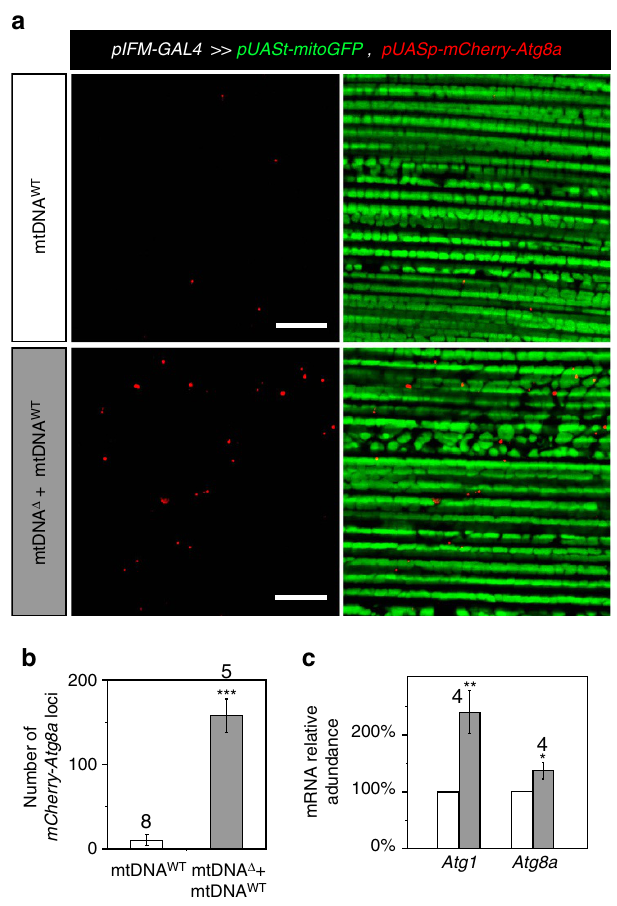
Figure 4 | Evidence for induction of autophagy in response to mtDNA D . ( a ) IFM from a 3-day-old wild-type animal expressing mitochondria- localized GFP ( mitoGFP ; green) and mCherry-Atg8a (red) under the control of pIFM-GAL4 (top panels), and a mitoAflIII -expressing, mtDNA D -bearing animal (lower panels). Scale bar, 10 m M. ( b ) Histogram quantifying abundance of mCherry-Atg8A associated structures in wild-type and mtDNA D -bearing IFMs. ( c ) Relative mRNA abundance of Atg1 and Atg8a in wild-type IFMs (mtDNA WT ), and IFMs from mitoAflIII animals containing mtDNA D (mtDNA D þ mtDNA WT ), at 3 days post eclosion. Bars depict mean ± 1 s.d. The number of biological replicate is indicated above the corresponding bars. Statistical significance was calculated using Student’s t- test with unequal variance. * P o 0.05, ** P o 0.01 and *** P o